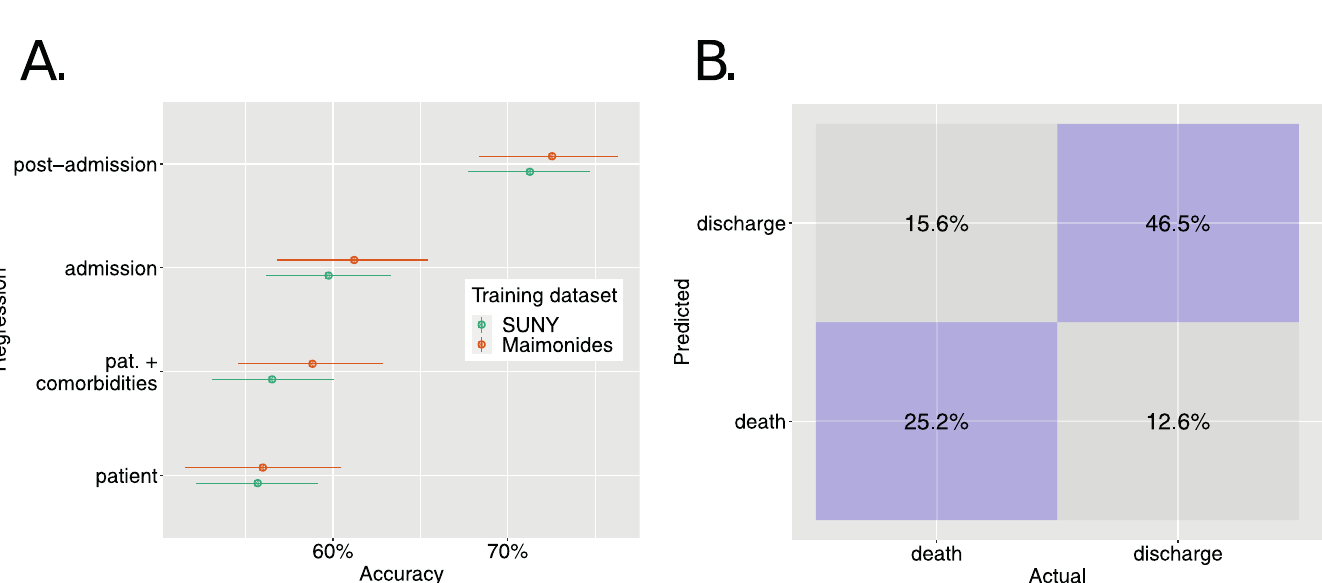
Fig 5. Model predictive accuracy in patient outcomes for held-out hospital. Panel A shows the accuracy in predicting outcomes across four regression sets. Colours indicate the hospital whose data was used to train the model: so, for example, “SUNY” indicates that data from this hospital was used to fit the model which was then tested on data from Maimonides. The horizontal axis shows the accuracy in predicting patient outcomes (i.e. death or discharge) using a Markov regression model with covariate sets as named on the vertical axis. The points and whiskers indicate the posterior medians and 2.5%-97.5% posterior intervals for the percentage of patients whose outcome was correctly determined across posterior draws. Panel B shows a confusion matrix for between-hospital prediction using Markov model with the post- admission covariate set. Here, the values show the mean percentage of each outcome type correctly predicted across all posterior samples.